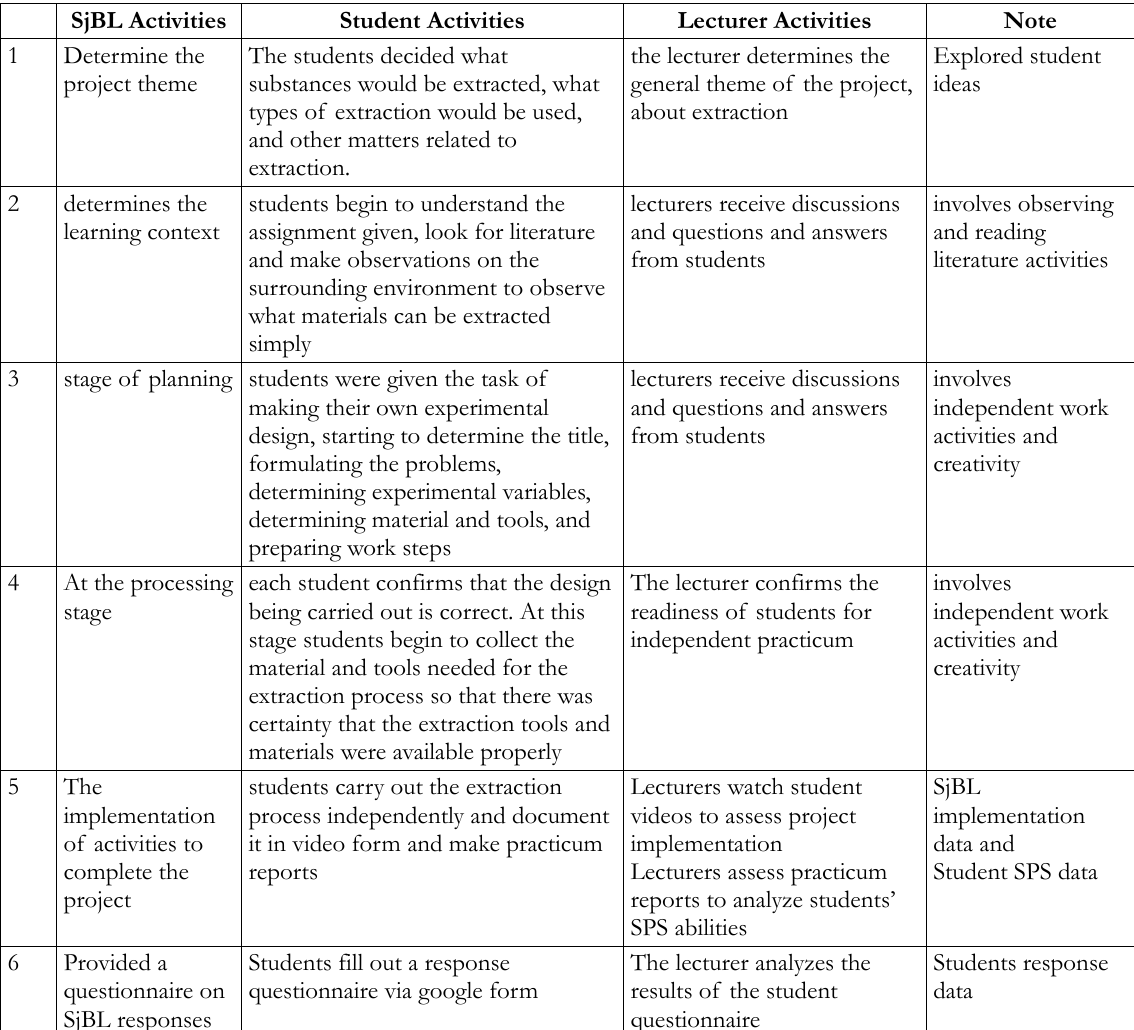
Table 1. activities of lecturers and students in